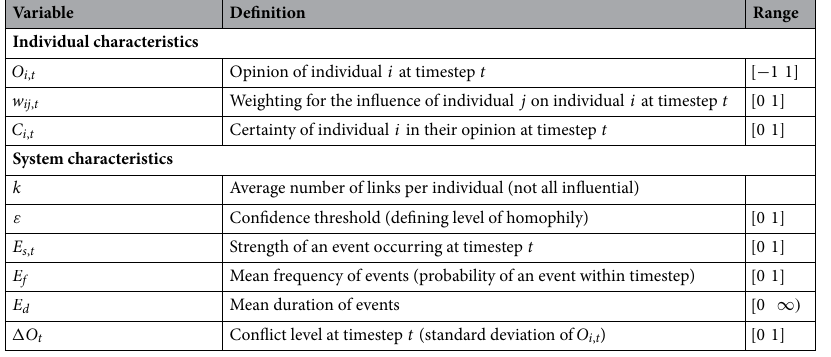
Table 2. Definitions of model variables describing both individual and system